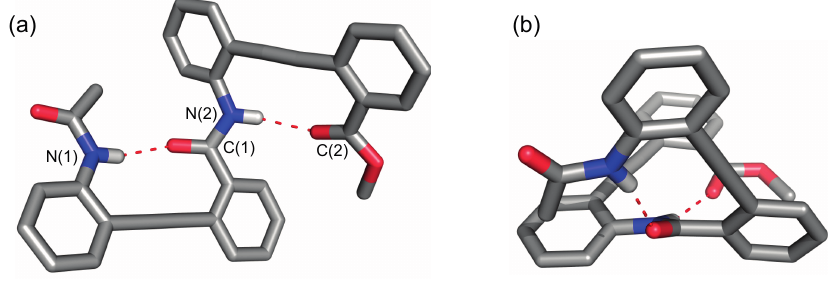
Figure 1. X-ray diffraction structure of 3 as viewed ( a ) perpendicular to and ( b ) along its helical axis. The left-handed folded structure and hydrogen atoms have been omitted for